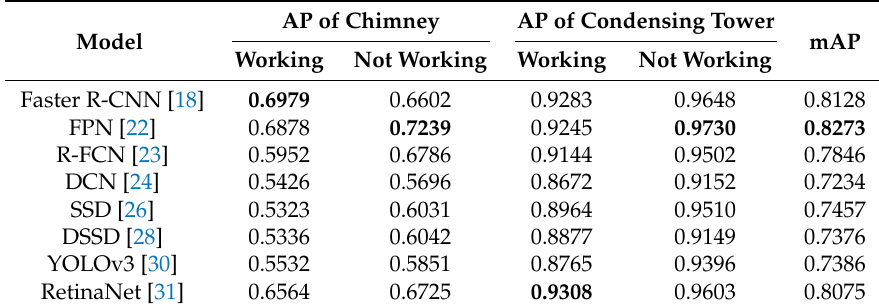
Table 5. Accuracy comparison of eight models for power plant monitoring. The bold font indicates the best